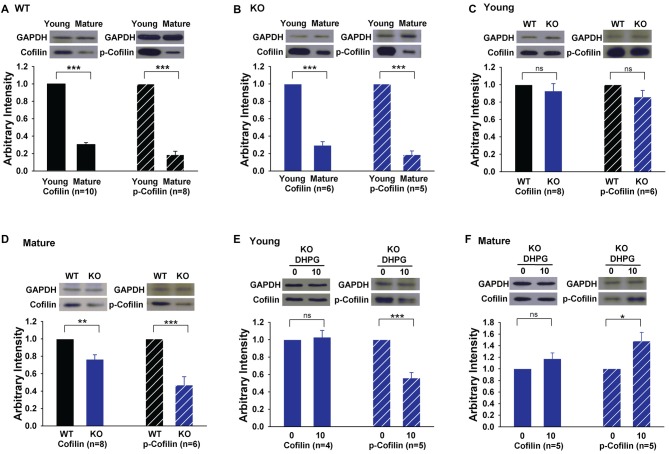
Expression of cofilin and phosphorylated cofilin (p-cofilin) in young and mature GluA2 KO mice. (A,B) Western blots showing that both total baseline cofilin and p-cofilin decrease in mature compared to young mice in both WT and GluA2 KO mice. ***p < 0.001 compared with young mice. (C,D) Western blots showing that baseline cofilin and p-cofilin are similar in WT and GluA2 KO young mice but significantly reduced in mature GluA2 KO mice compared to mature WT mice. **p < 0.01, ***p < 0.001 compared with WT mice, ns: not significant (p > 0.05). (E,F) DHPG activates cofilin in young but not in mature GluA2 KO mice. *p < 0.05, ***p < 0.001 compared with untreated group, ns: not significant (p > 0.05).